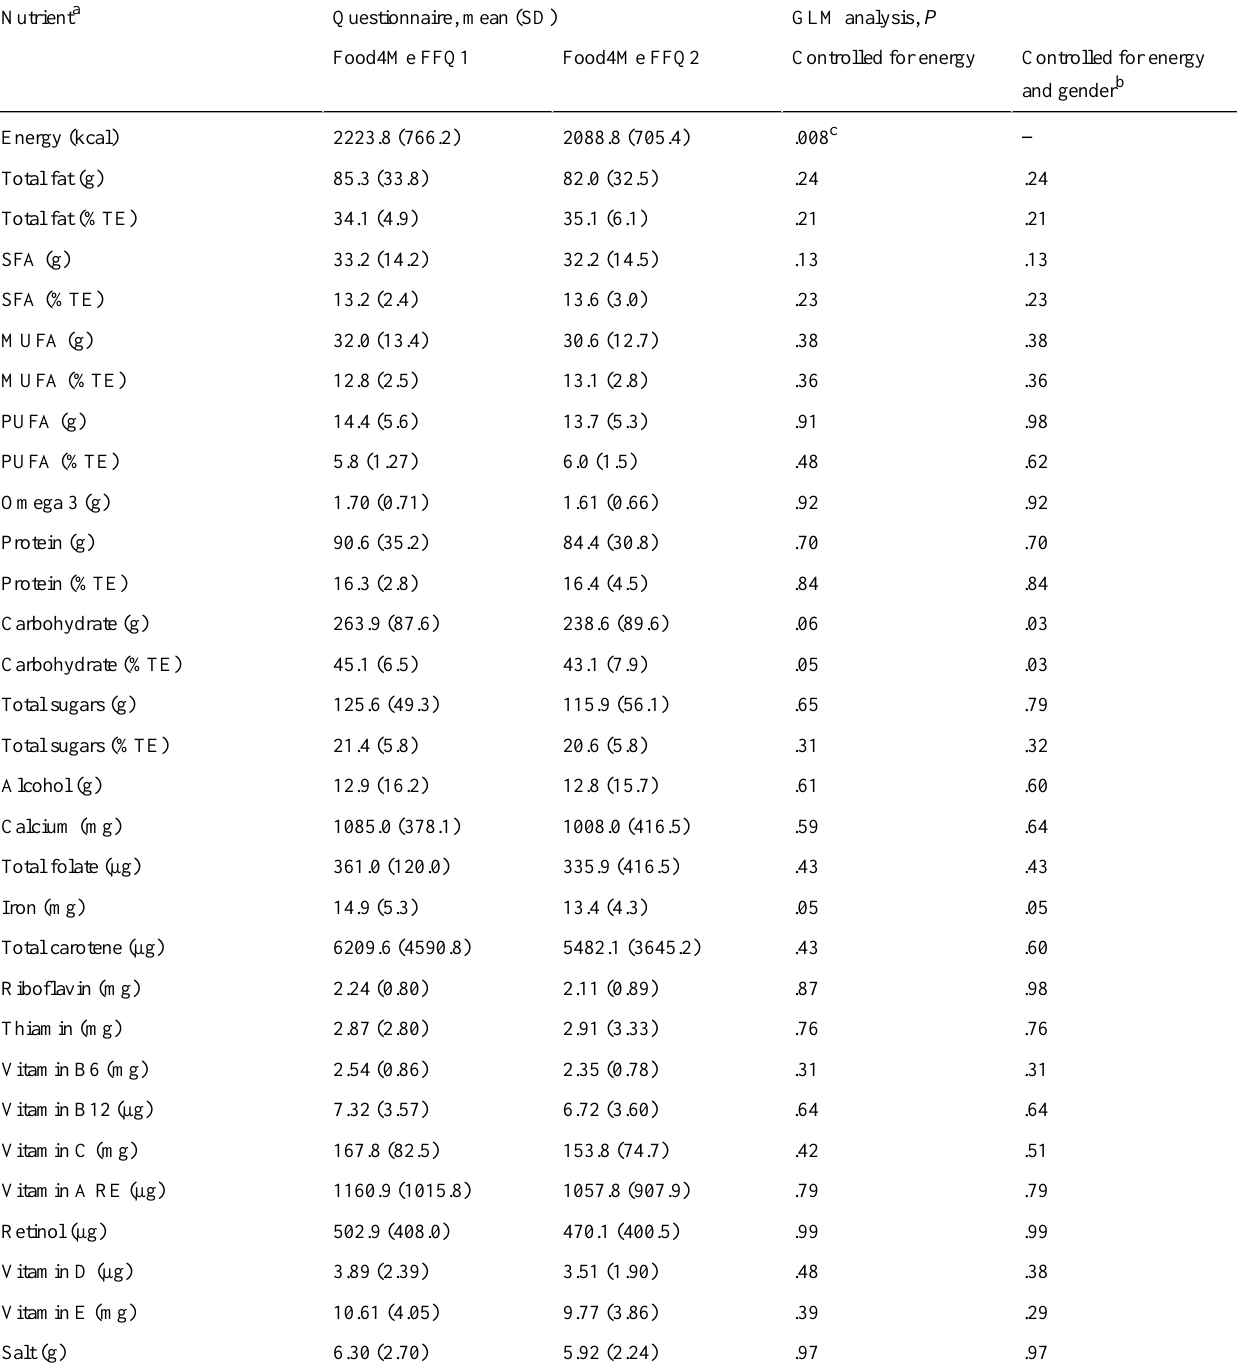
Table 2. Mean daily energy and nutrient intakes estimated by repeated measures of the online Food4Me FFQ and general linear model (GLM) results (N=100).